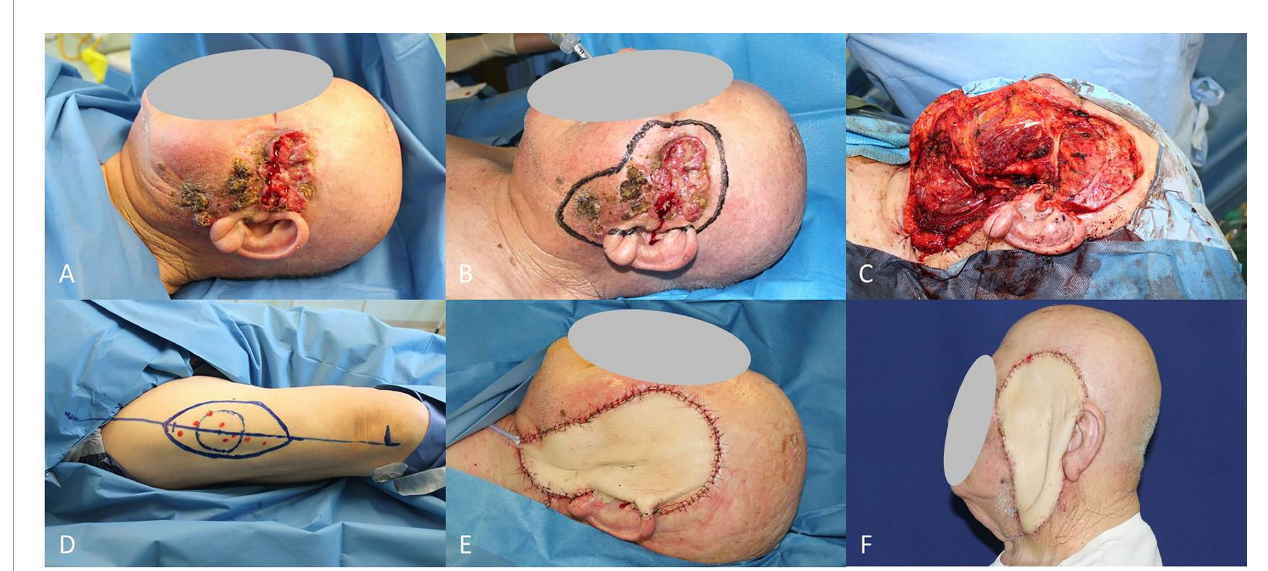
FIGURE 9 | (A) Locally advanced SCC of left midface; (B) Planning of the wide excision; (C) Soft and hard tissues removed, lymphadenectomy completed; (D) Planning of the ALT fl ap harvest; (E) Immediate result after the ALT fl ap insetting; (F) Final result at 30 days